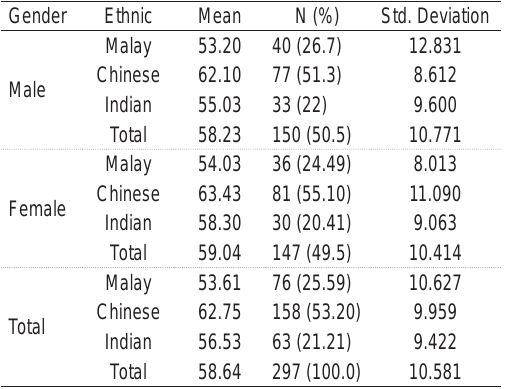
TABLE 2. Mean age gender distribution among ethnic TABLE 4. Characteristic determination of RF2 –hypertension during study duration